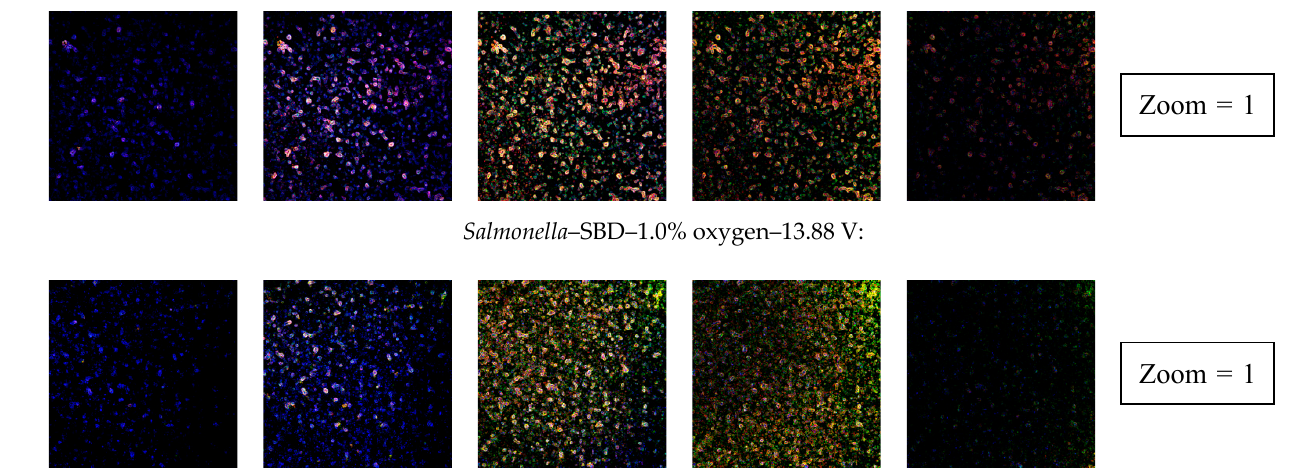
Figure 9. Two-dimensional CLSM images taken at different depths of the (CAP treated) model biofilms, with images from left to right going from the top to the bottom layers of the biofilm ( n = 1). Images have been provided for both biofilm forming species and for each examined combination of plasma characteristics (i.e., DBD/SBD, He + 0/1% ( v/v ) oxygen, and 13.88/21.88 V input voltage). CAP treated and control biofilms were always stained with a mixture of calcofluor white (EPS, blue emission), SYTO9 (living cells, green emission), and propidium iodide (dead/damaged cells, red emission) prior to the visualization step. Depending on the viability of the biofilm-associated cells and the presence of EPS components within a specific biofilm layer, this resulted in two-dimensional images with different staining patterns.